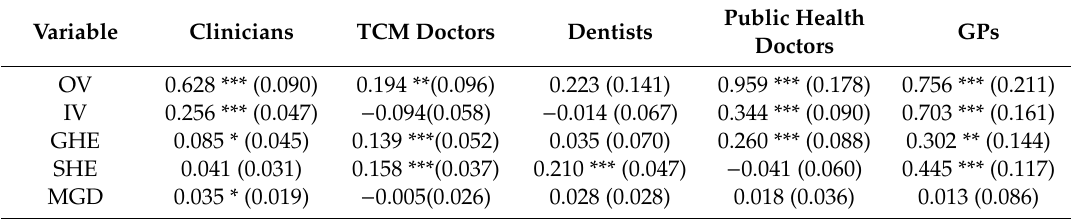
Table 5. Direct e ff ects of independent variables on the density of di ff erent subtypes of licensed doctors.